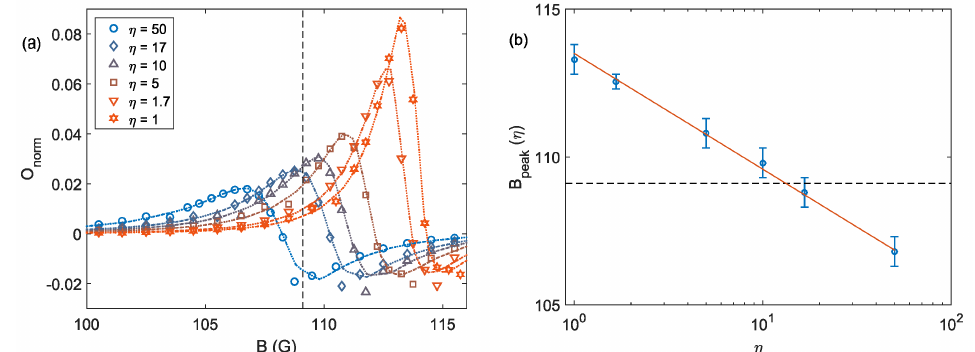
Figure 4. ( a ) Numerical second derivative of the normalized overlap, O norm . We identify the peak position of each curve as the magnetic field value, B peak , for which the normalized overlap changes the most indicating the transition from immiscible to miscible. The dotted lines serve only as guide to the eyes. In ( b ), we show B peak as a function of η in a semilog scale which gives a logarithm dependence of B peak with the atom number ration. The red solid curve is a fit to the data points (see main text) and the black dashed line represents B 0 with δ = 0.